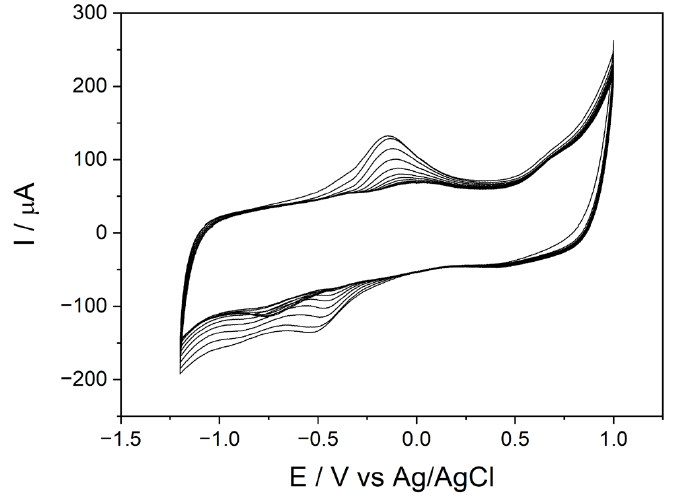
Figure 5. Regeneration of MWCNT-CS- based sensors (acetate buffer 0. 1 M, pH 5, v = 0.05 V/s, n = 12 cycles). n = 12